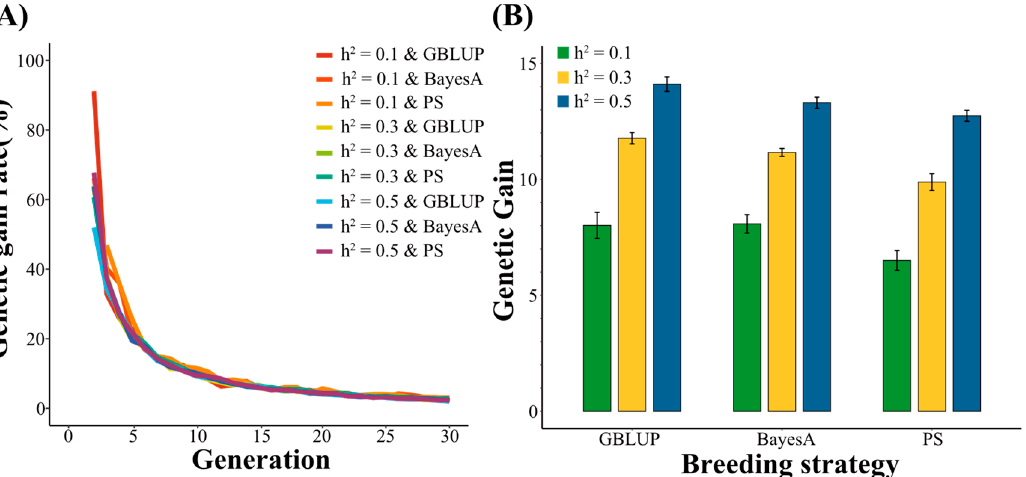
Figure 2. ( A ) Genetic gain rates across 30 generations for all scenarios using 54 K SNPs. ( B ) The genetic gains of the 30th generation based on 54 K SNPs for different heritabilities.